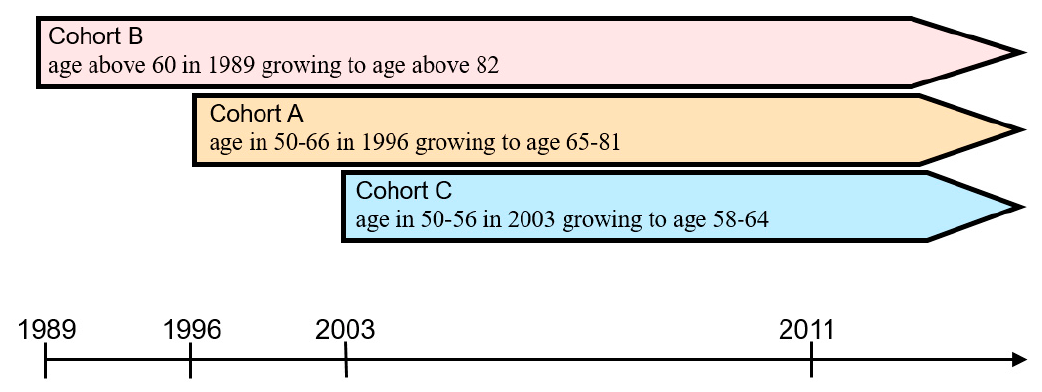
Figure 1. Surveyed samples of the middle-aged and over in Taiwan.